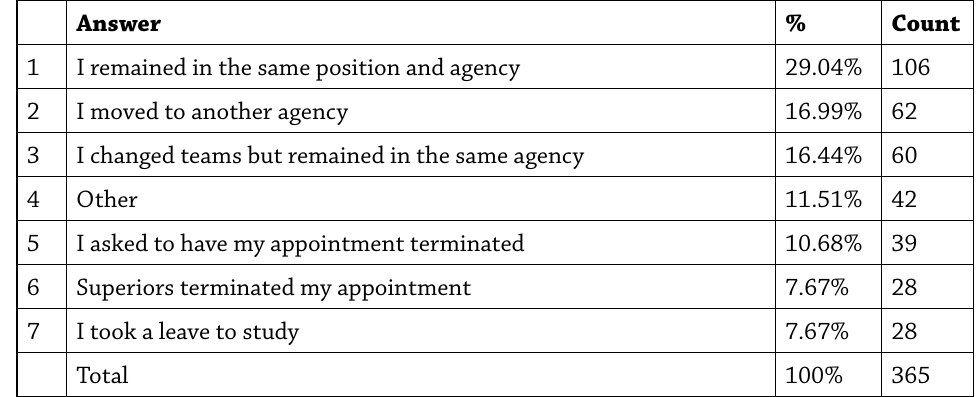
Table 3. Career decisions between the 2016 impeachment and the 2018 elections Answer %